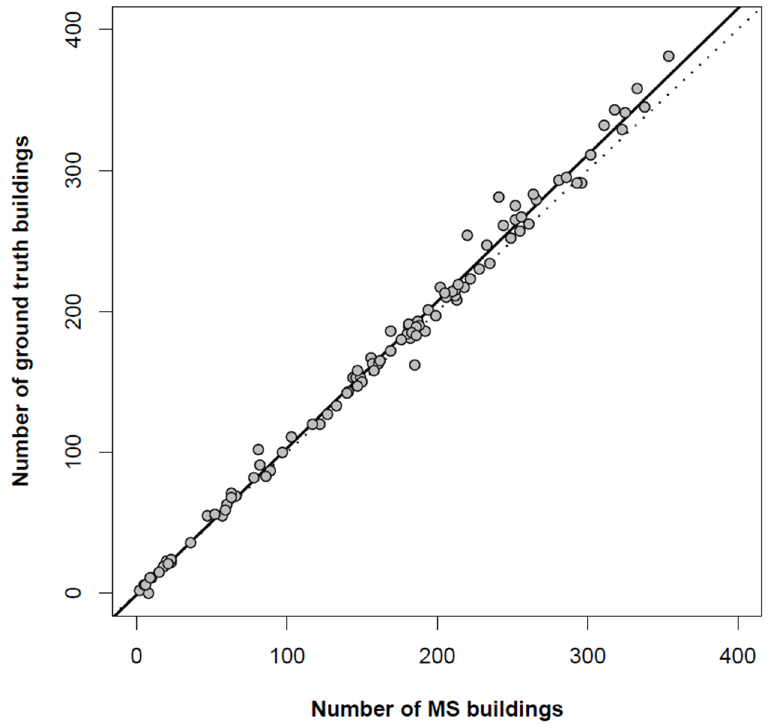
Figure 4. The relationship between the number of ground-truth buildings and the number of buildings in the MS dataset, across 99 sampling areas of 250 m radius. The dotted line is the 1:1 slope with zero intercept, whereas the solid line depicts the slope of a simple linear model fit to the data.